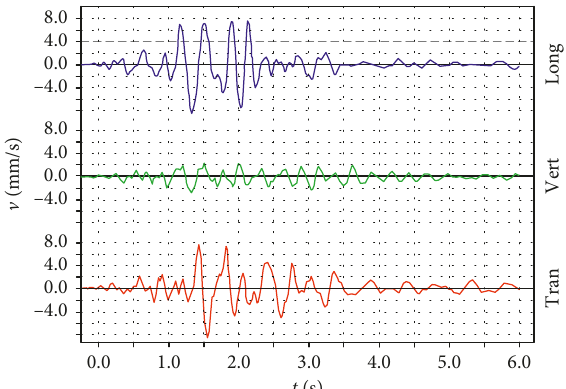
Figure 10: Typical waveforms associated with blasting-induced